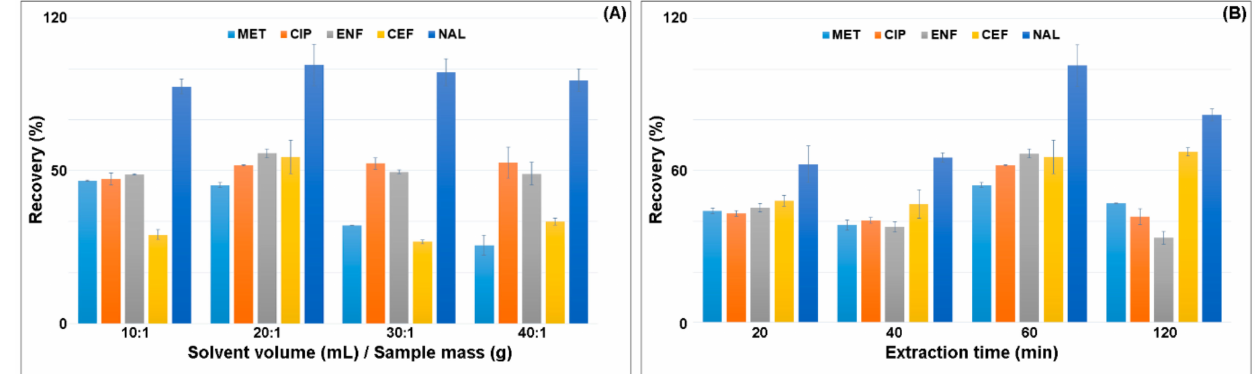
Figure 3. Effect of the ( A ) ratio of the mass of the sample to the volume of the solvent and ( B ) extraction time on the recovery of